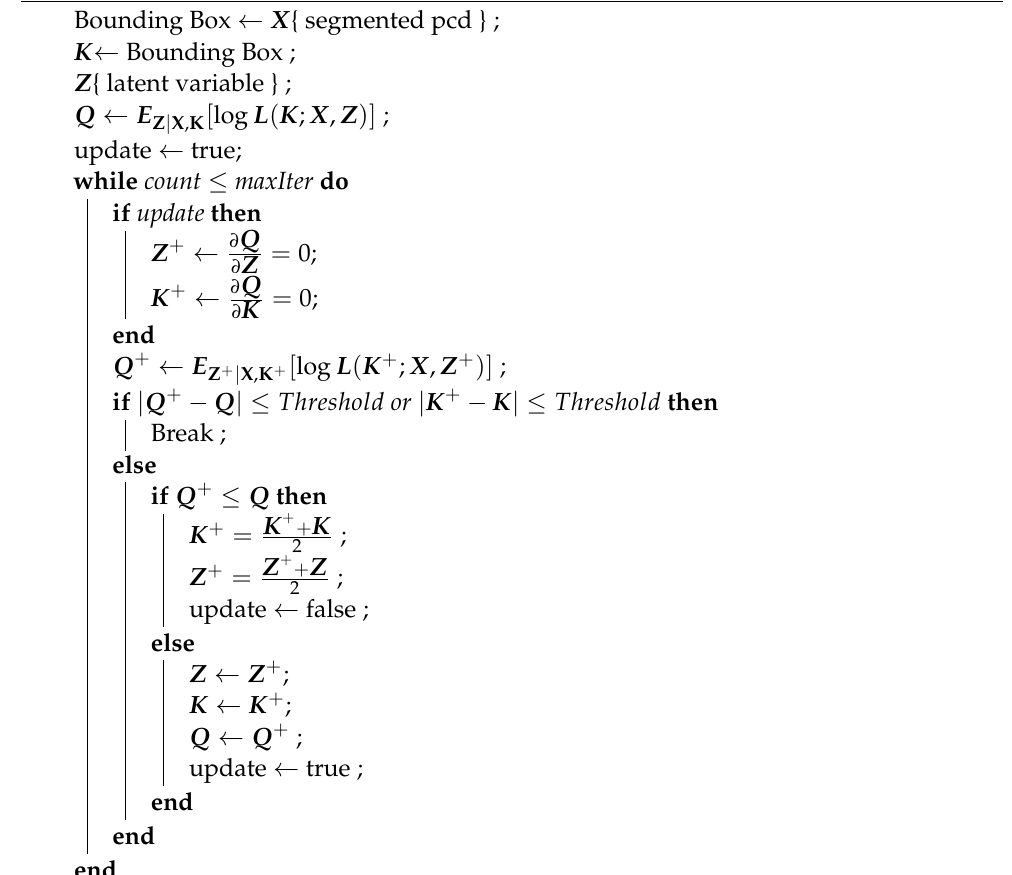
Algorithm 1: Cuboid